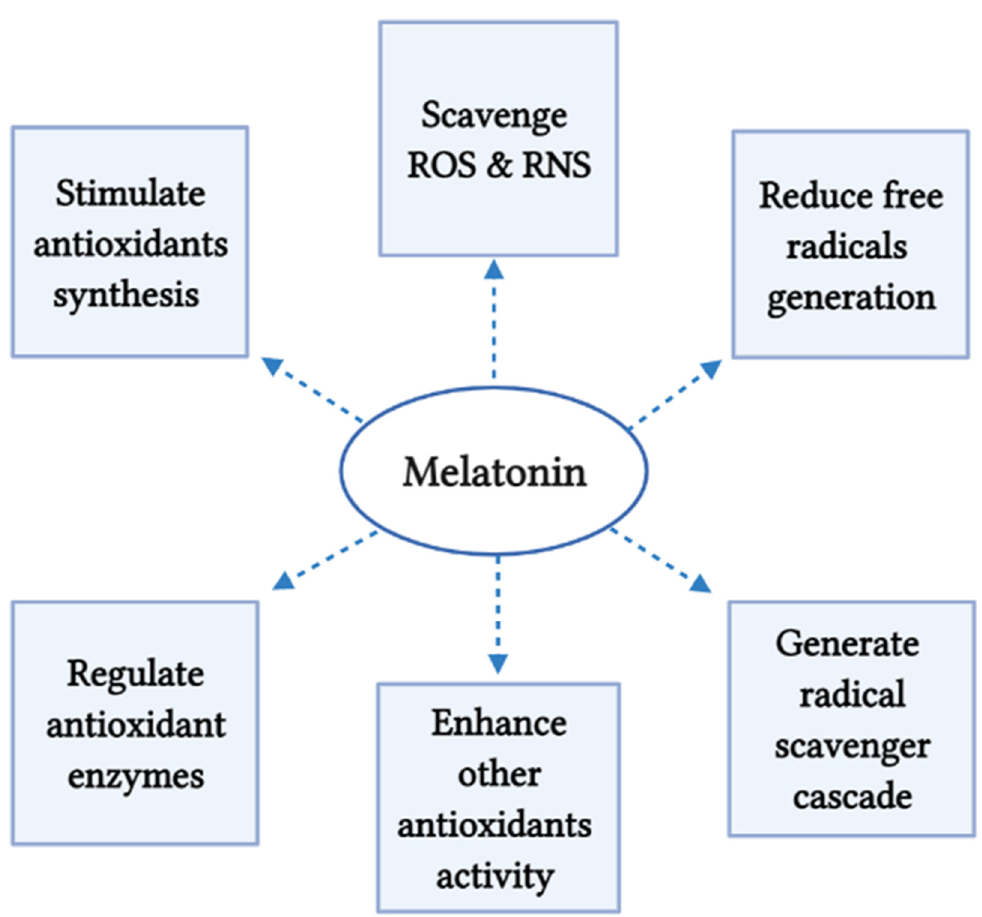
Figure 2. Melatonin’s mechanisms as antioxidant. ROS, reactive oxygen species; RNS, reactive nitrogen species.